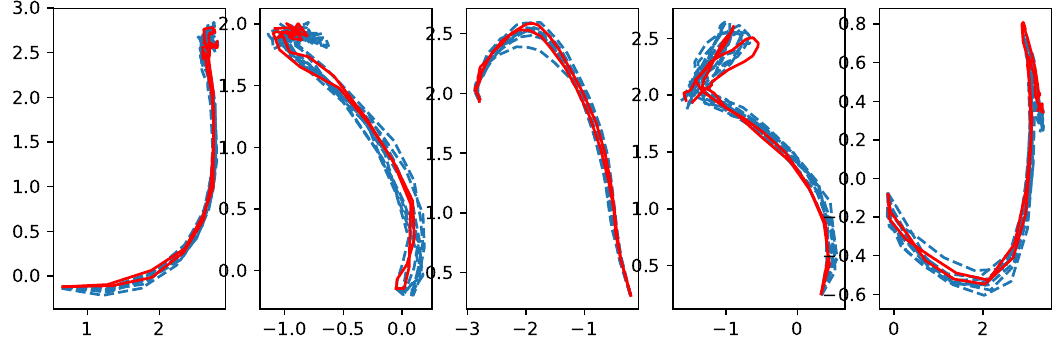
Figure 11. Cross-validation results for the coach’s skills (from left to right): Forehand stroke, forehand drive, forehand cut, backhand drive, backhand short.